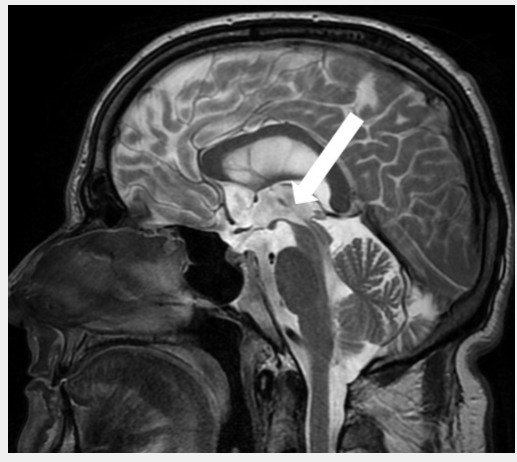
Brain MRI (T2) in sagittal plane of a patient with progressive supranuclear palsy (PSP). Note the marked midbrain atrophy adopting the appearance of a “hummingbird”